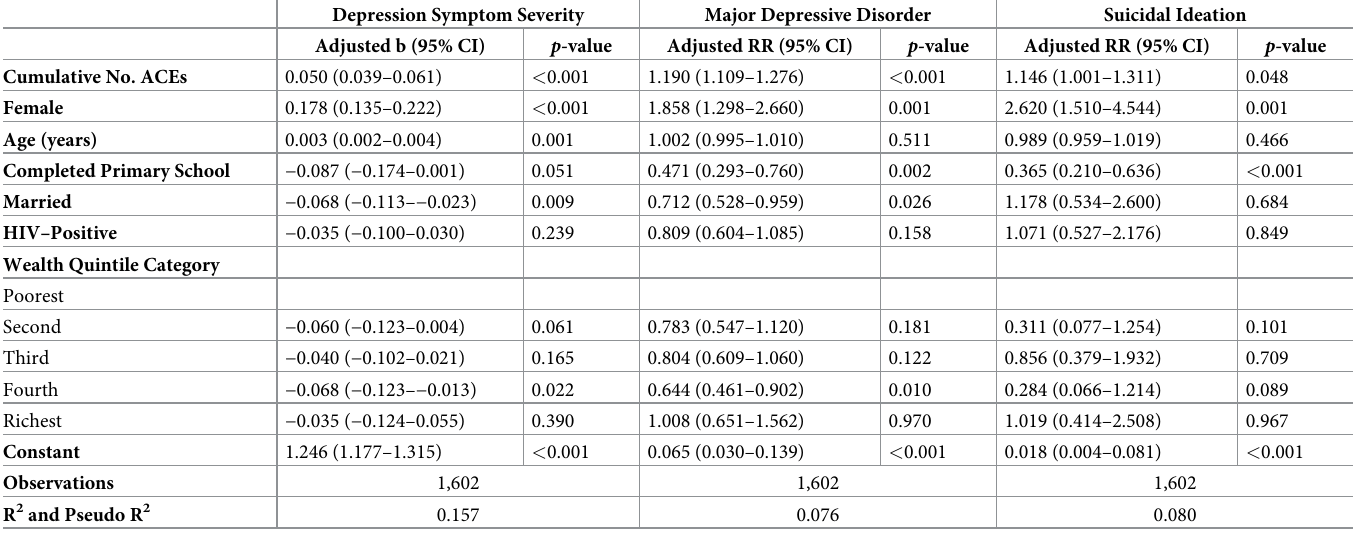
Table 3. Adjusted linear and Poisson regression models estimating associations between number of ACEs and depression symptom severity, major depressive dis- order, and suicidal